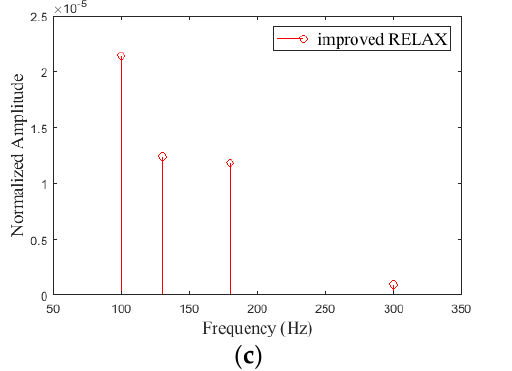
Figure 6. The underwater sound source sends four different frequency signals. The results of differ- ent frequency estimation algorithms based on ( a ) periodogram that presents large side lobes, ( b ) RELAX that misses the 300 Hz signal, and ( c ) improved RELAX, which has estimated results con- sistent with the frequency of the transmitted sound source.